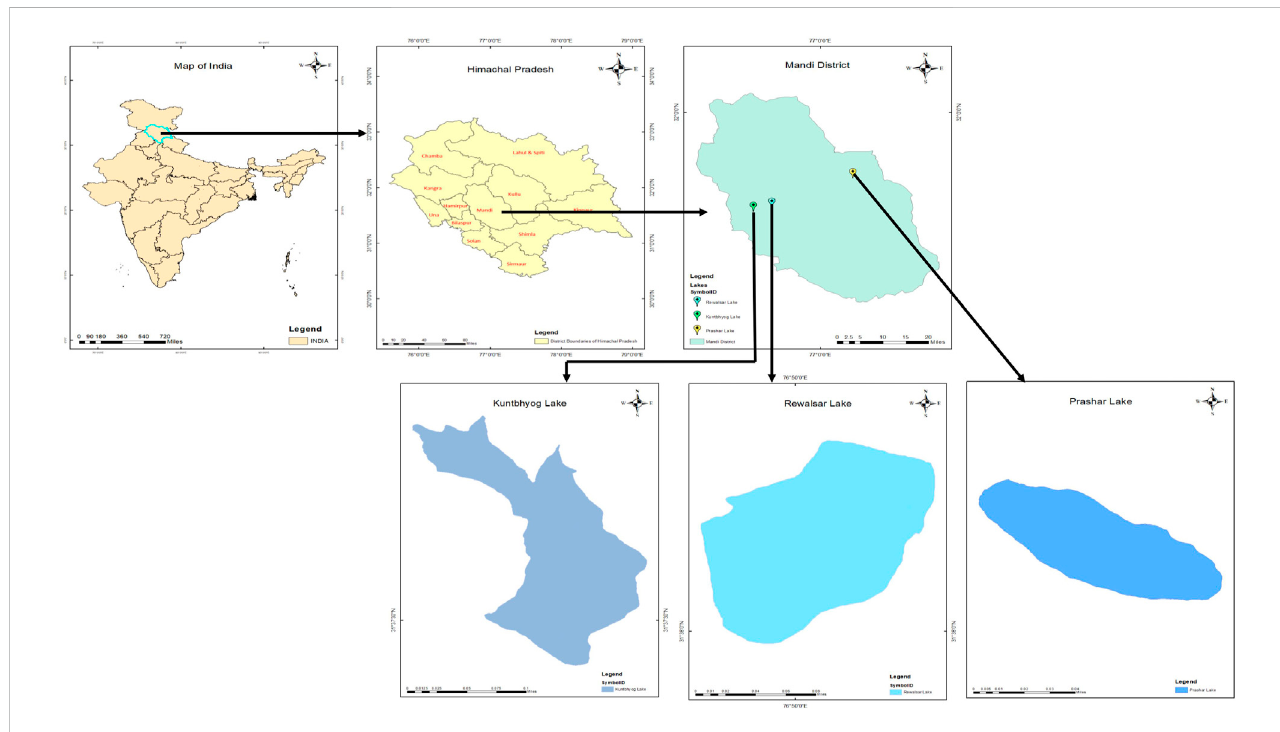
FIGURE 1 ArcGIS map showing the selected sampling lakes in Himachal